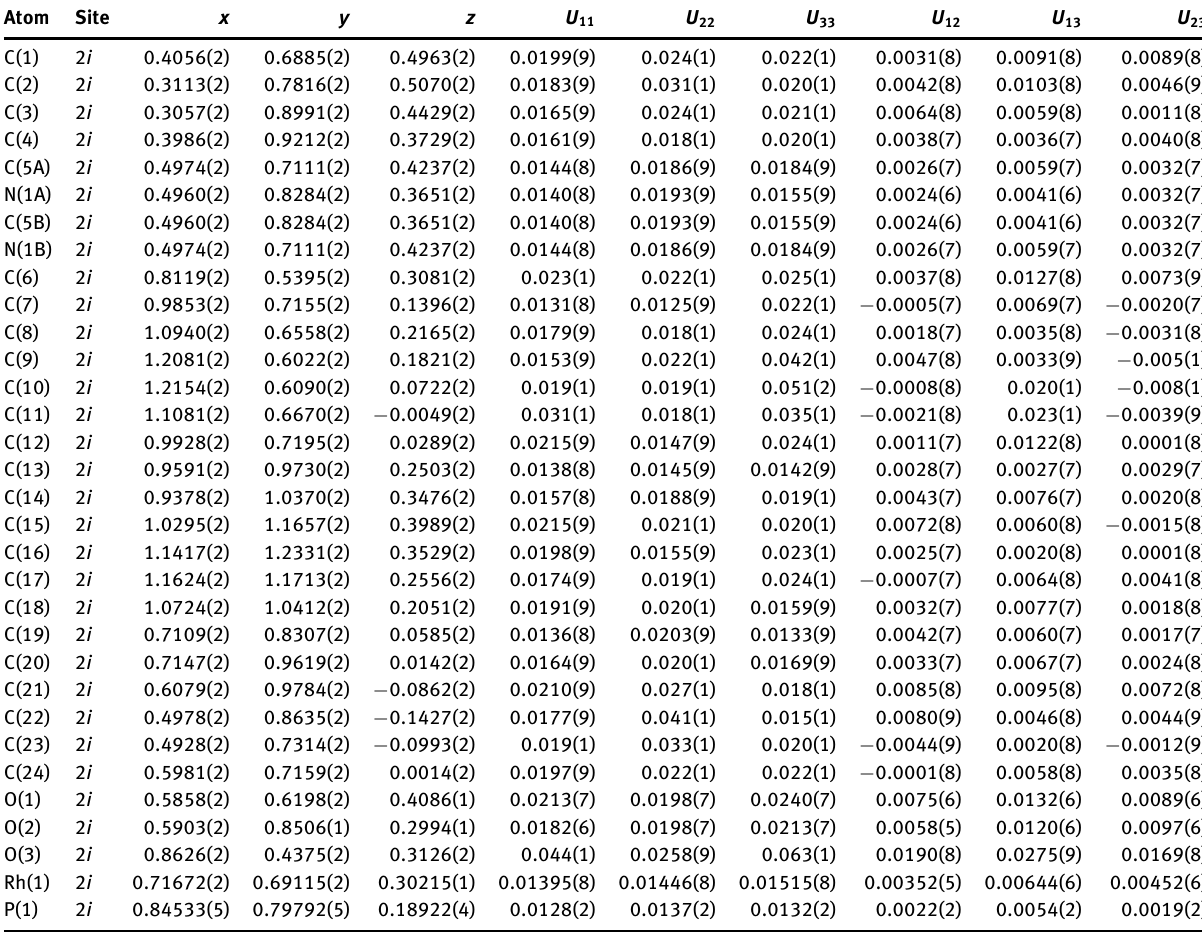
Table 3: Fractional coordinates and atomic displacement parameters (Å 2